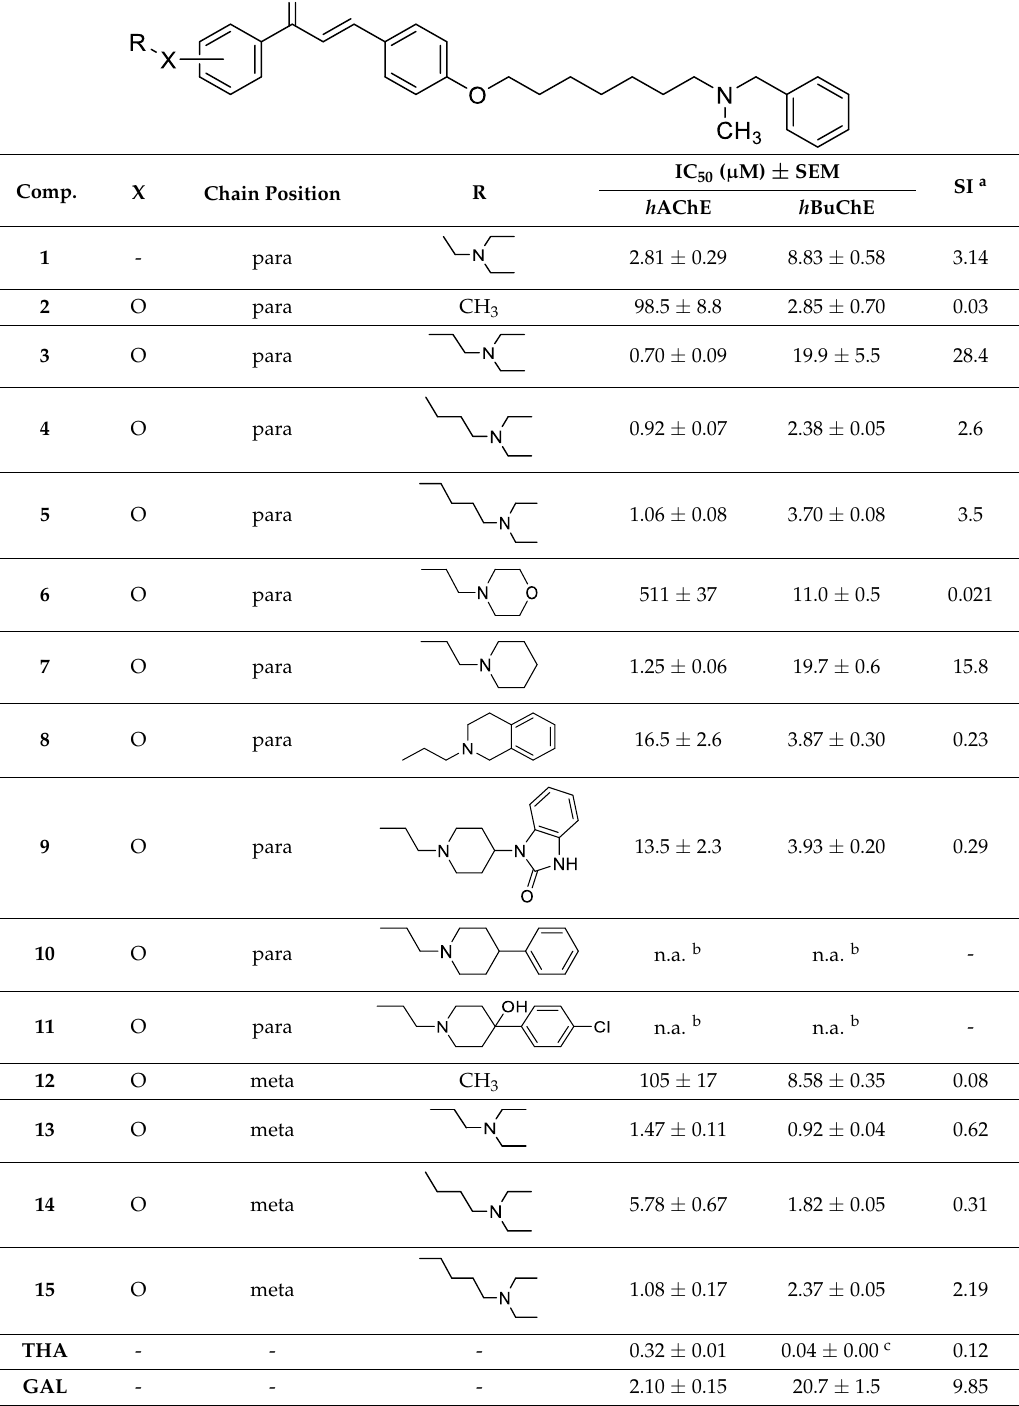
Table 1. Inhibitory activities against h AChE and h BuChE, as IC 50 values, of compounds 1 – 15 and reference compounds tacrine (THA) and galantamine (GAL). Comp.